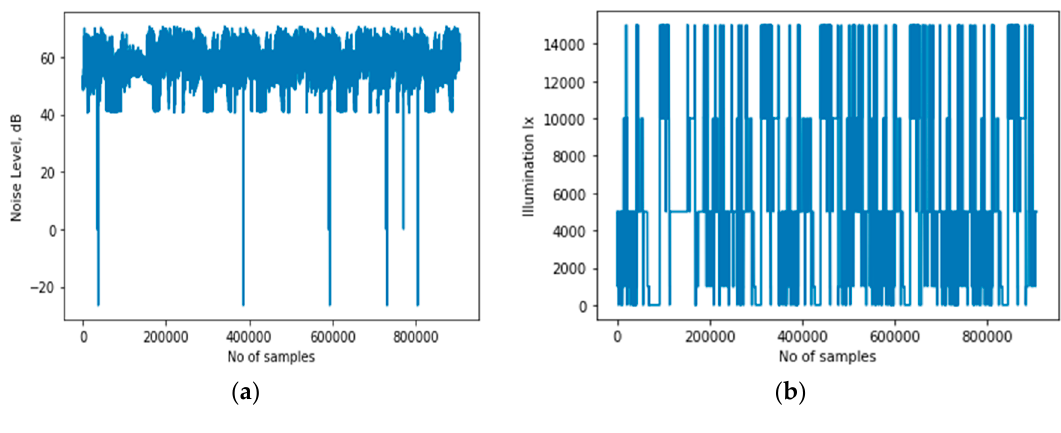
Figure 7. 1D audio ( a ) and light ( b ).